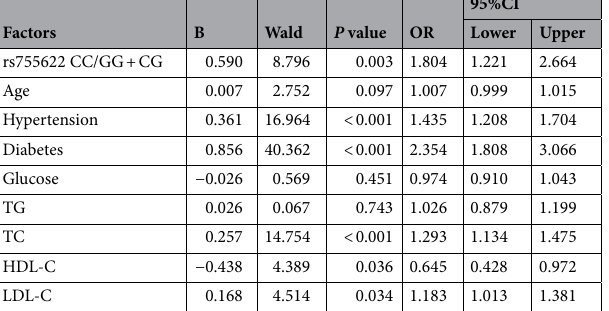
Table 3. Multiple logistic regression analysis for CAD risk factors. TG triglyceride, TC total cholesterol, HDL- C high-density lipoprotein-cholesterol, LDL-C low density lipoprotein-cholesterol.